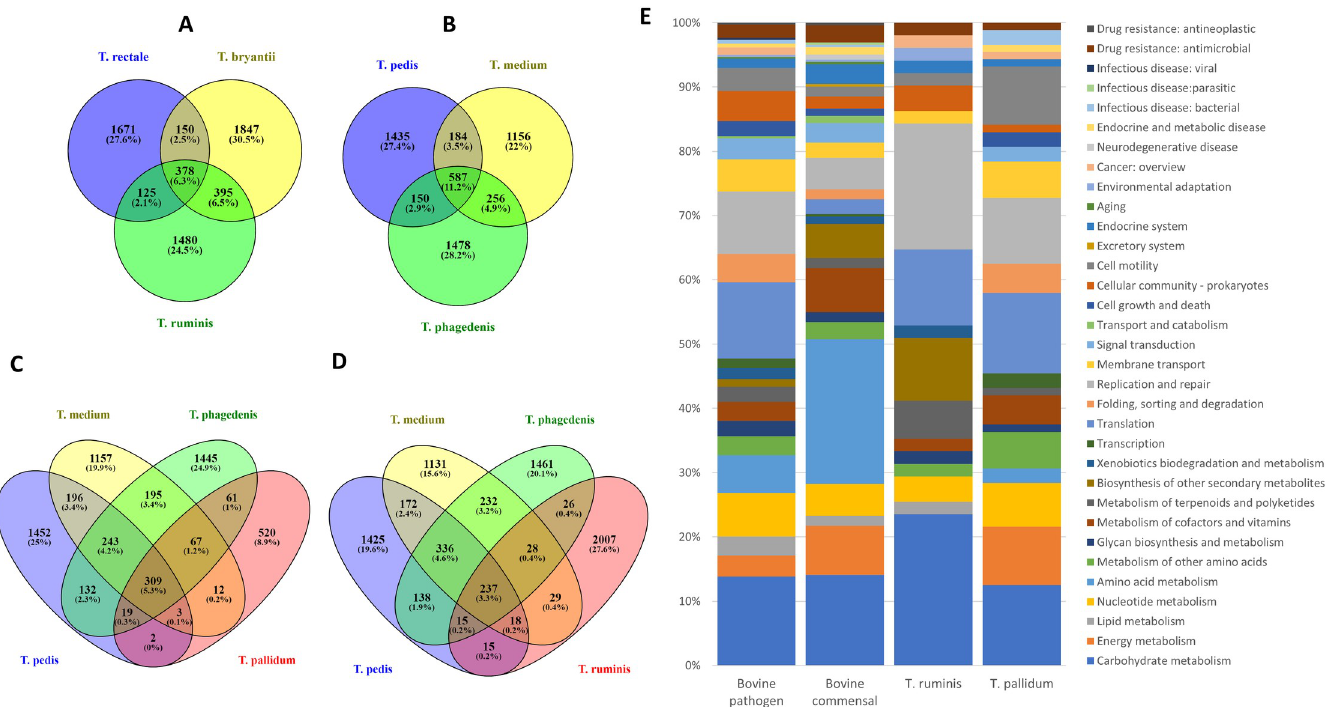
Fig 2. Core, accessory and unique genes shared between bovine digital dermatitis and bovine gastrointestinal treponemes or shared between bovine digital dermatitis treponemes with the pathogen Treponema pallidum or the commensal gastrointestinal Treponema ruminis . Venn diagram representation of the core, accessory and unique genes shared between bovine GI treponemes ( A ) and bovine digital dermatitis treponemes ( B ) or shared between bovine digital dermatitis treponemes with the pathogen Treponema pallidum ( C ) or the commensal GI Treponema ruminis ( D ). Numbers of shared gene families and/or unique genes are listed with the percentage of the total pan-genome this represents (for each comparison) listed in parentheses. E: After the core treponeme genome shared between the BDD treponemes and bovine GI treponemes were removed, functional annotation was carried out on the shared unique genes for the BDD treponemes and the bovine GI treponemes. Only 189 entries (79.4%) annotated of the 238 uniquely shared genes across the bovine GI treponemes could be annotated ( Bovine Commensal ), only 325 entries (74.2%) annotated of 438 uniquely shared genes across the BDD treponemes could be annotated ( Bovine Pathogen ). After the core treponeme genome shared between the BDD treponemes and both T . pallidum and T . ruminis were removed, functional annotation was carried out on remaining uniquely shared genes with either T . pallidum or T . ruminis . Only genes that could be assigned a KEGG category are represented in the bar graphs. Only 96 entries (75.0%) annotated of the 128 uniquely shared genes between BDD treponemes and T . pallidum could be annotated, only 47 entries (92.2%) annotated of 51 uniquely shared genes between BDD treponemes and T . ruminis could be